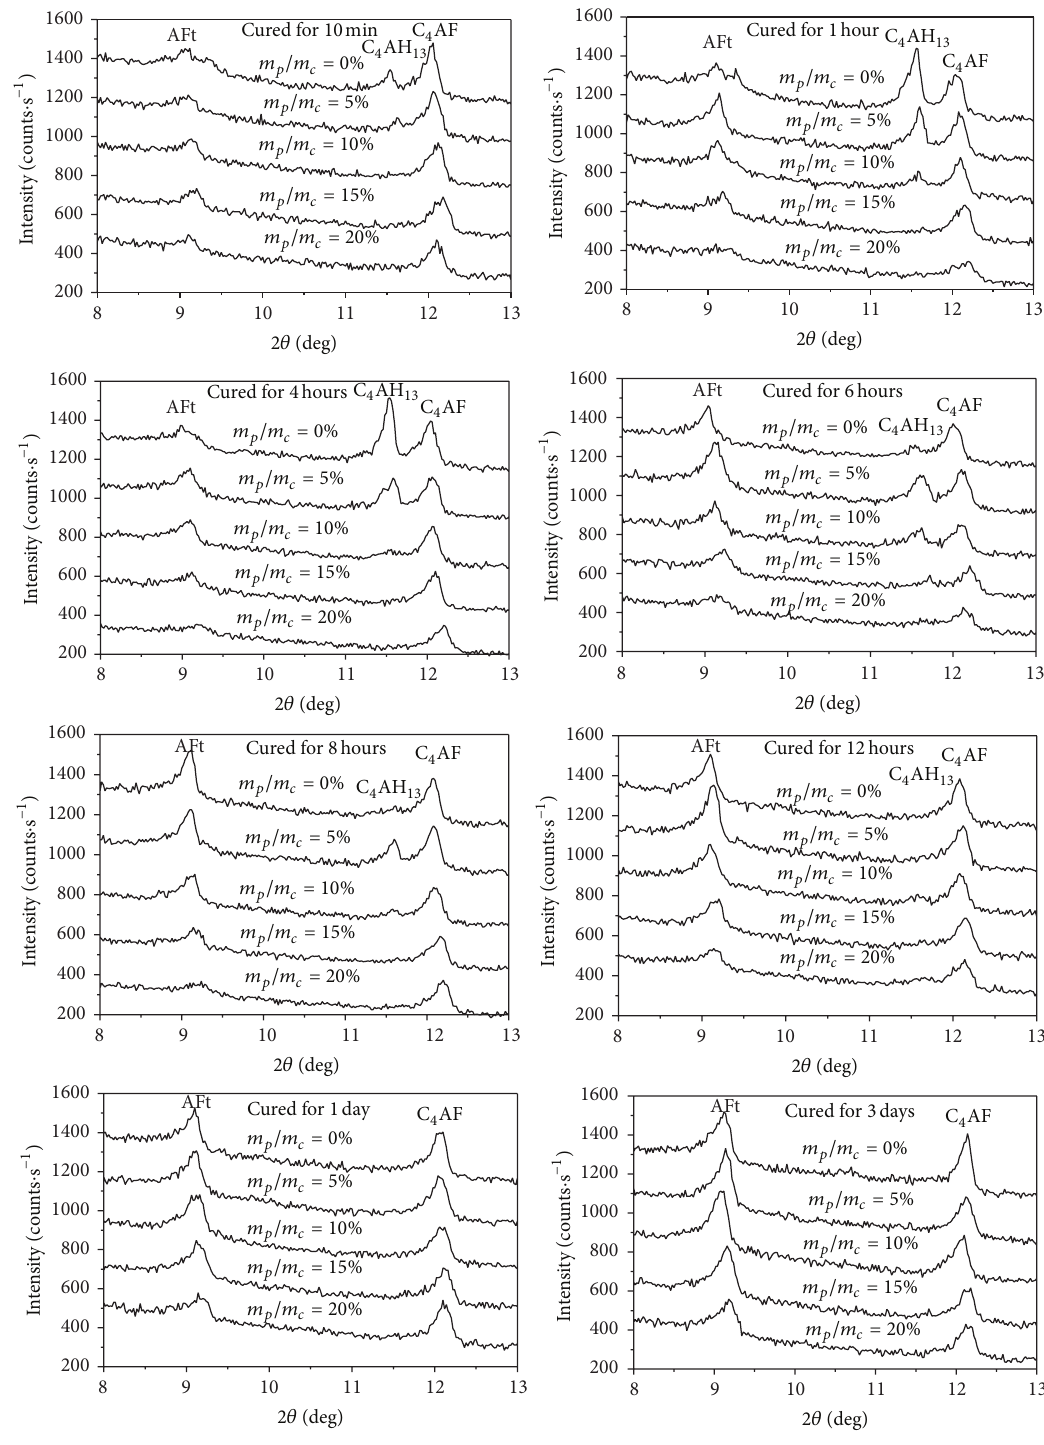
Figure 3: XRD patterns of cement pastes with SAE dispersion at 2𝜃 range of 8 ∘ –13 ∘